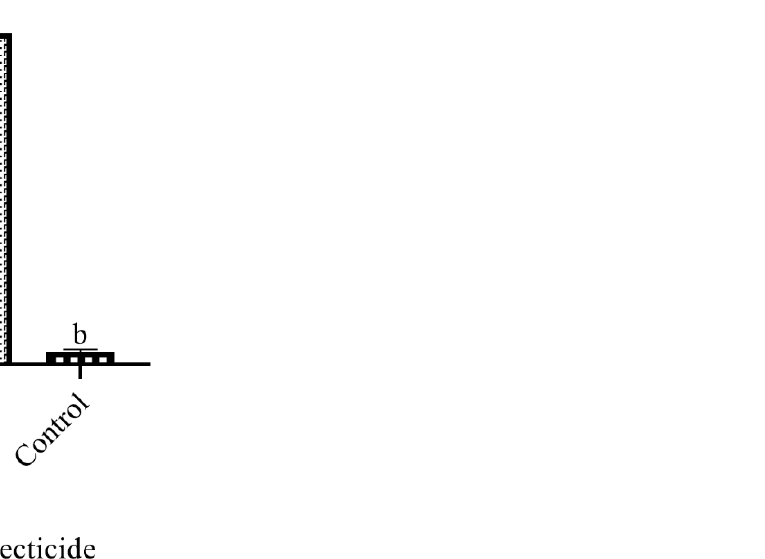
Figure 5. % mortality of females Ae. aegypti to different insecticides. These letter shows significant difference among treatments.